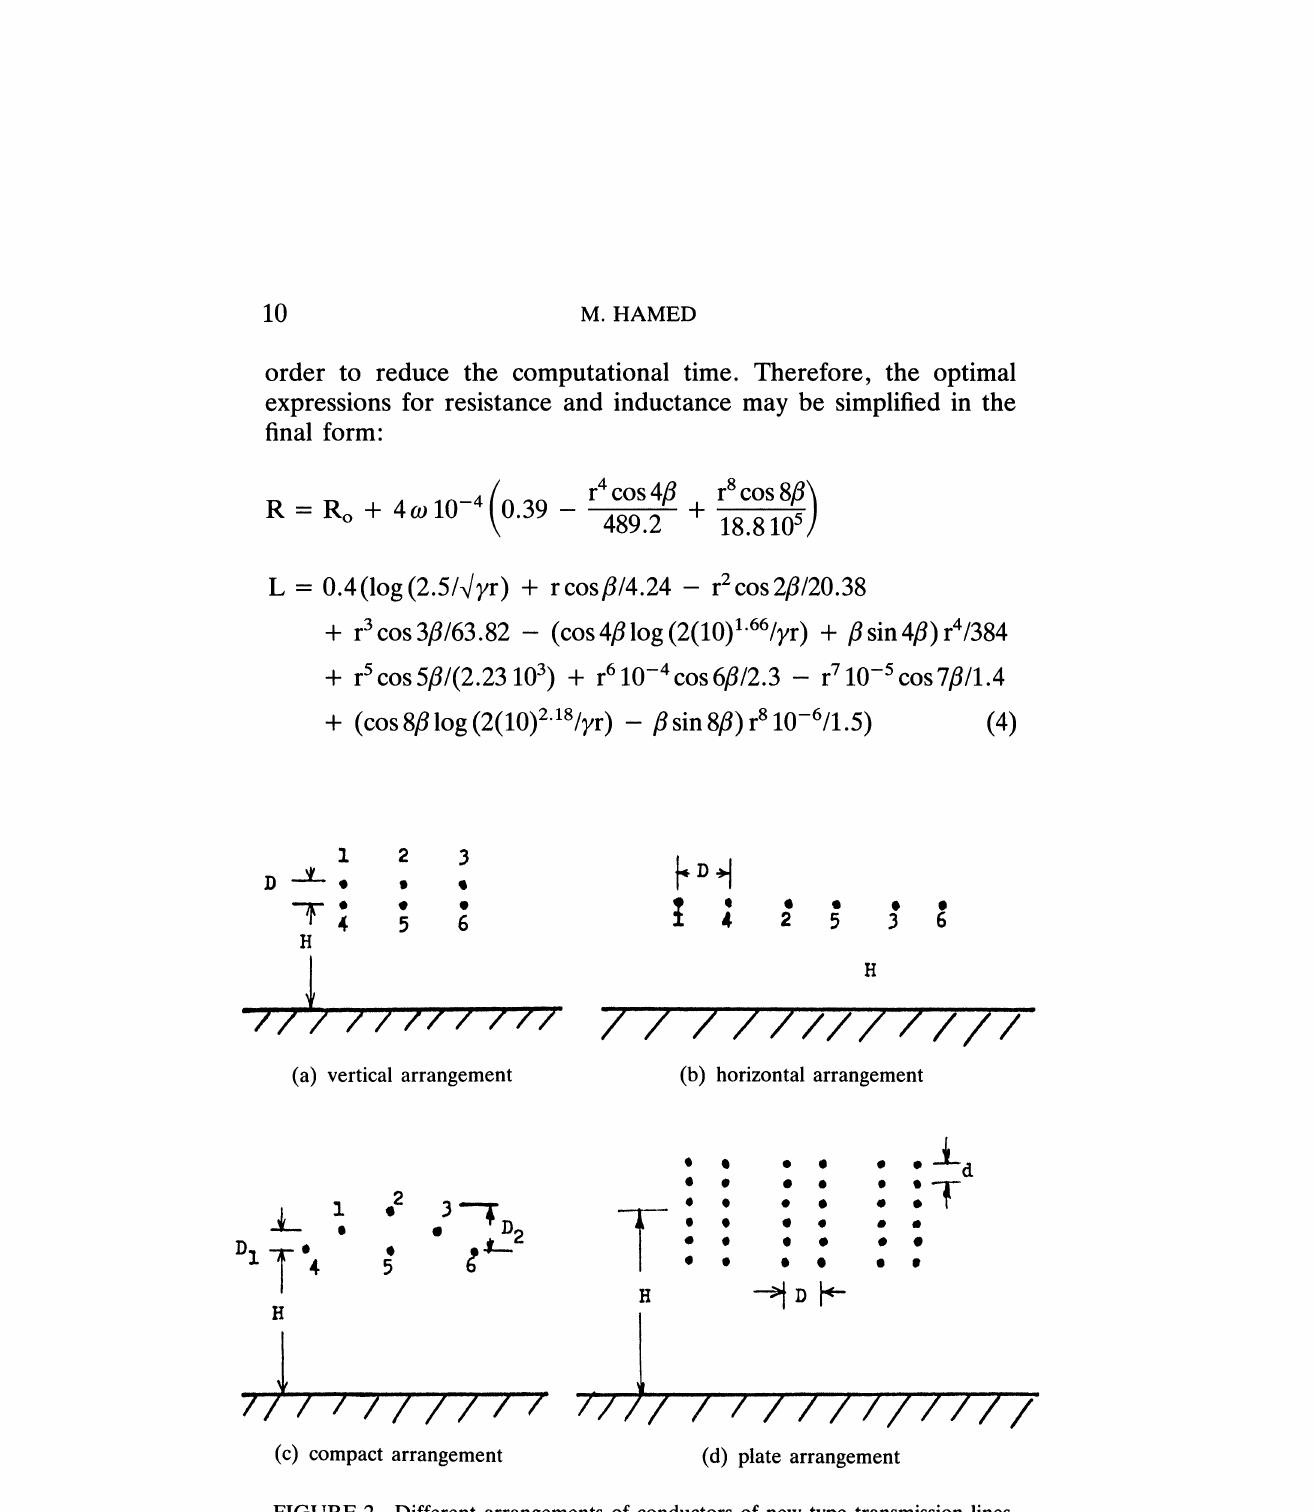
FIGURE 2 Different arrangements of conductors of new type transmission